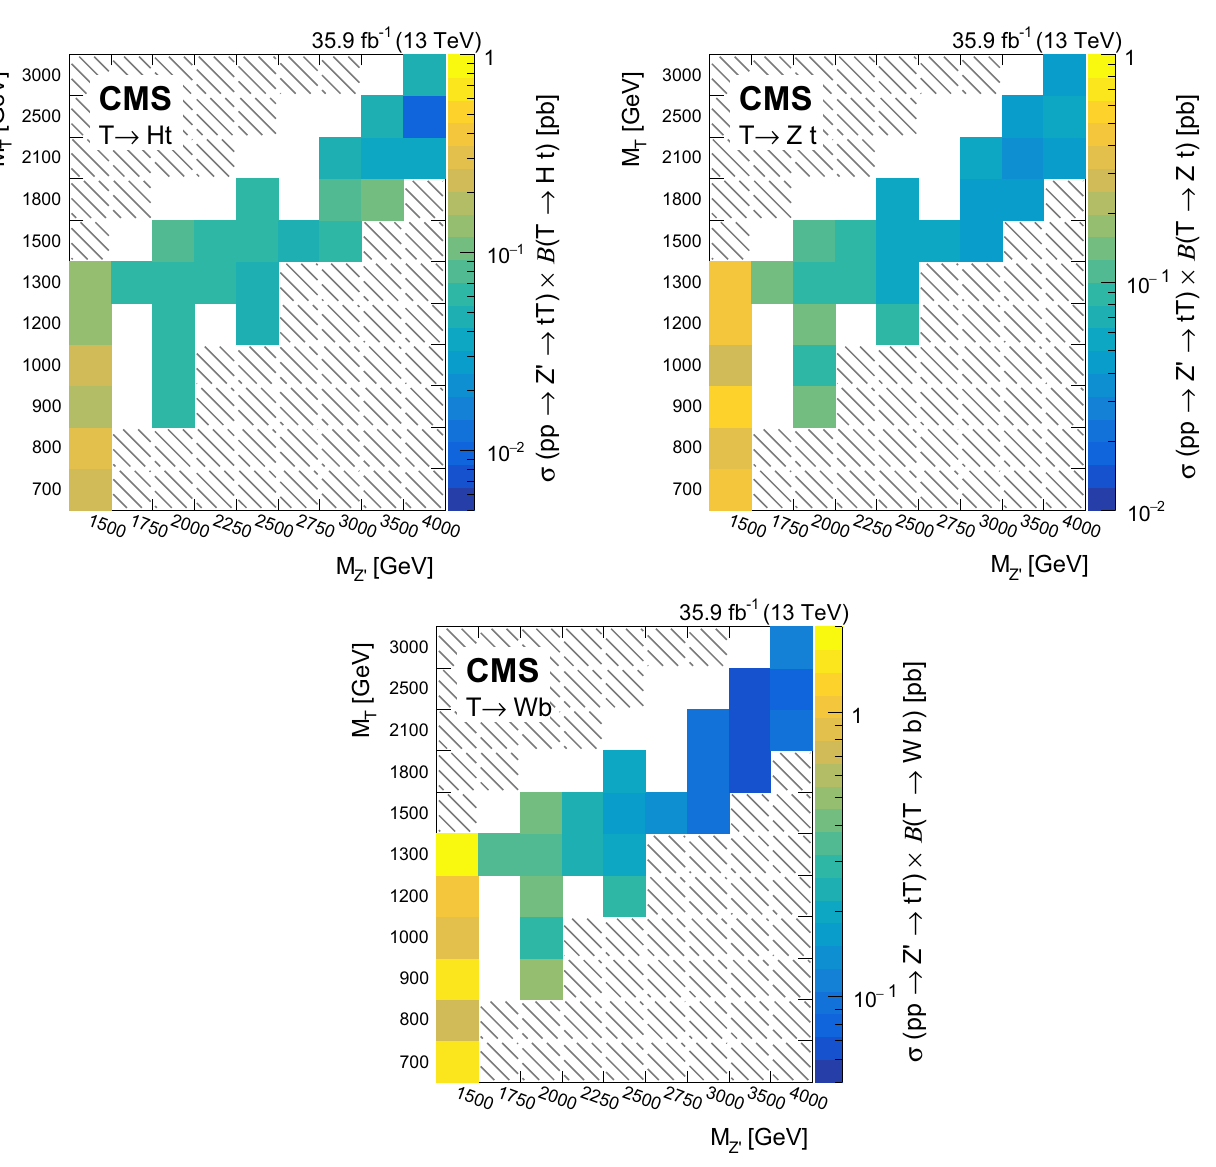
Fig. 7 Observed exclusion limits at 95% CL on the production cross section for various ( M Z (cid:3) , M T ) combinations for the decay channels T → Ht (upper left), T → Zt (upper right), and T → Wb (lower). The hatched area in the upper left indicates the region where the Z (cid:3) → tT